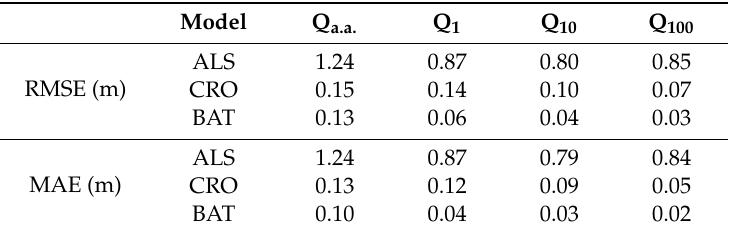
Table 8. RMSE and MAE values for WSE